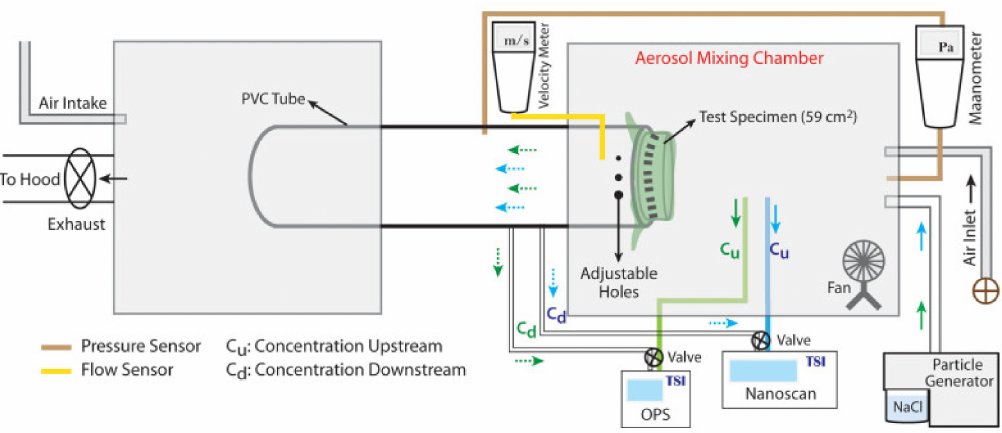
Figure 3. Illustration of filtration efficiency test setup using aerosolized NaCl. Reprinted with permission from [71]. Copyright © 2020 American Chemical